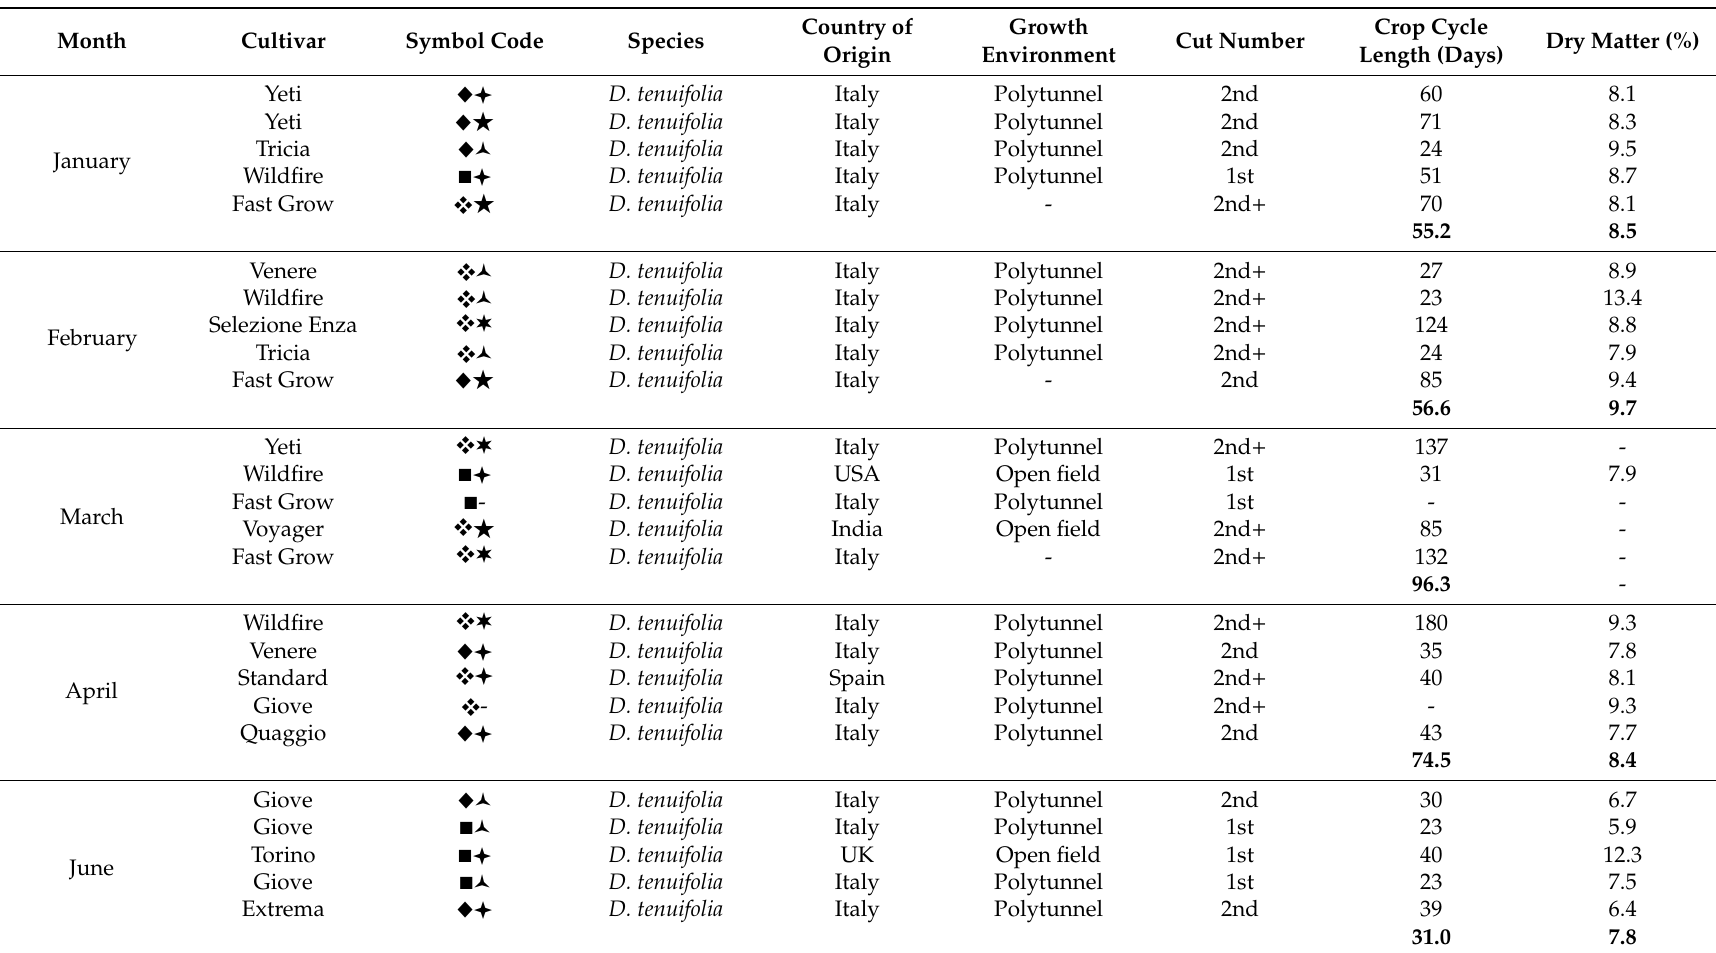
Table 1. Cultivation and origin details of rocket samples used for sensory and consumer analyses.